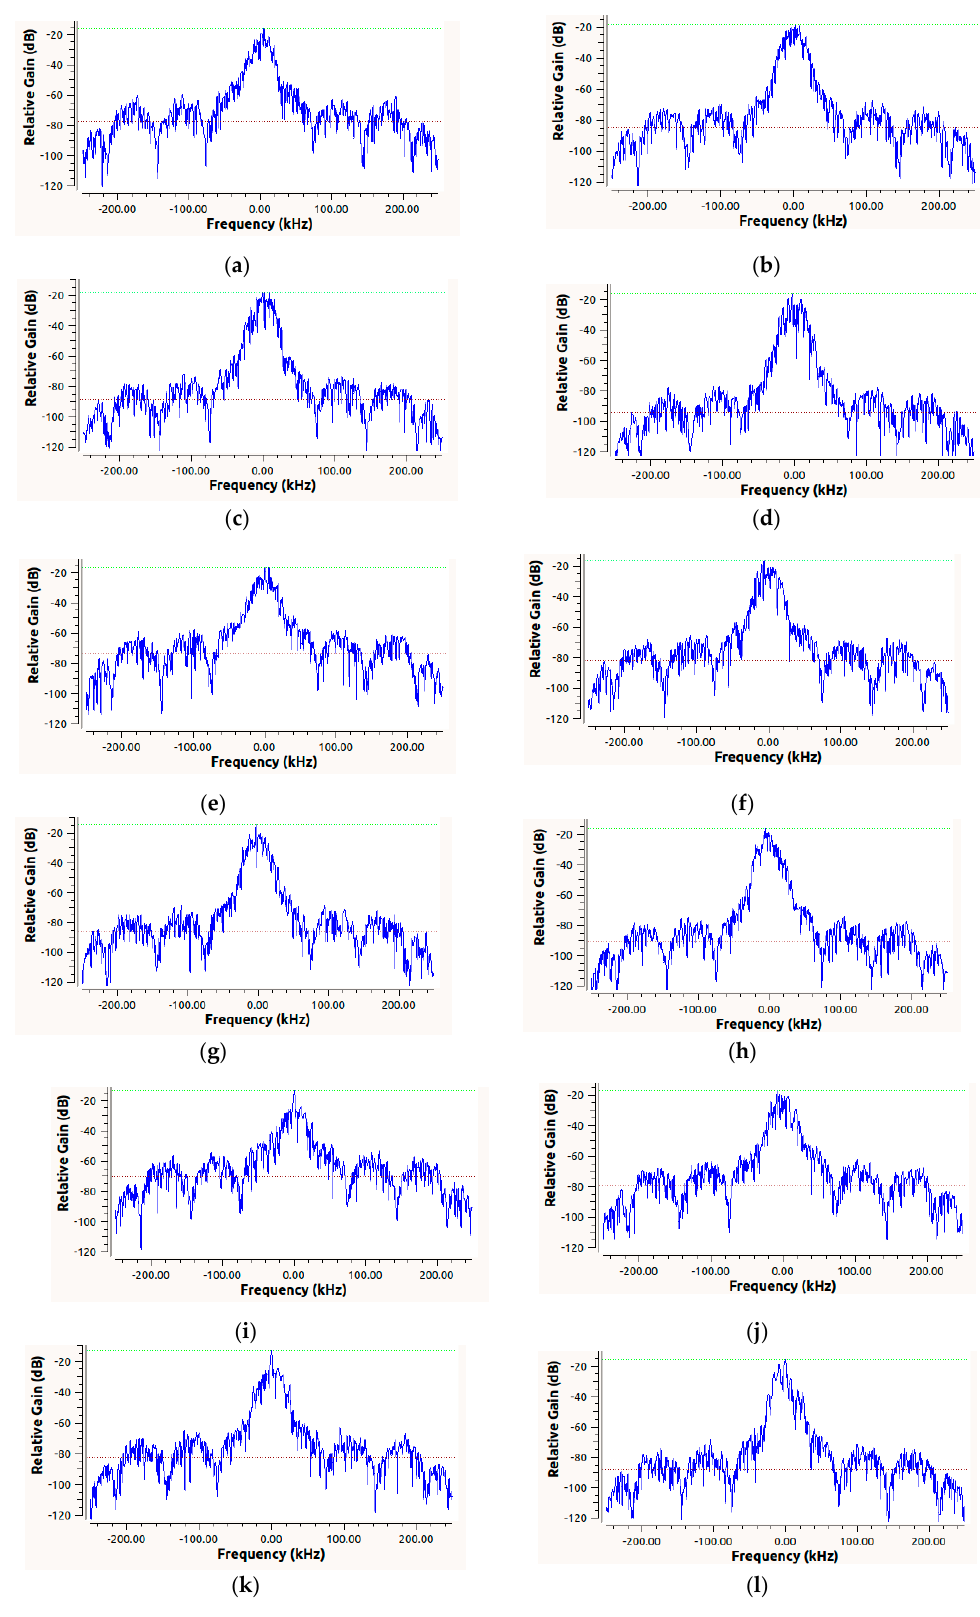
Figure 14. ( a – d ) Comparison of signals received in the 2400 bps GMSK mode with different SNR values. ( a ) SNR = − 3, ( b ) SNR = 5, ( c ) SNR = 9, ( d ) SNR = 14. ( e – h ) Comparison of the signals received in the 4800 bps GMSK mode with different SNR values. ( e ) SNR = − 3, ( f ) SNR = 5, ( g ) SNR = 9, ( h ) SNR = 14. ( i – l ) Comparison of the signals received in the 9600 bps GMSK mode with different SNR values. ( i ) SNR = − 3, ( j ) SNR = 5, ( k ) SNR = 9, ( l ) SNR = 14.